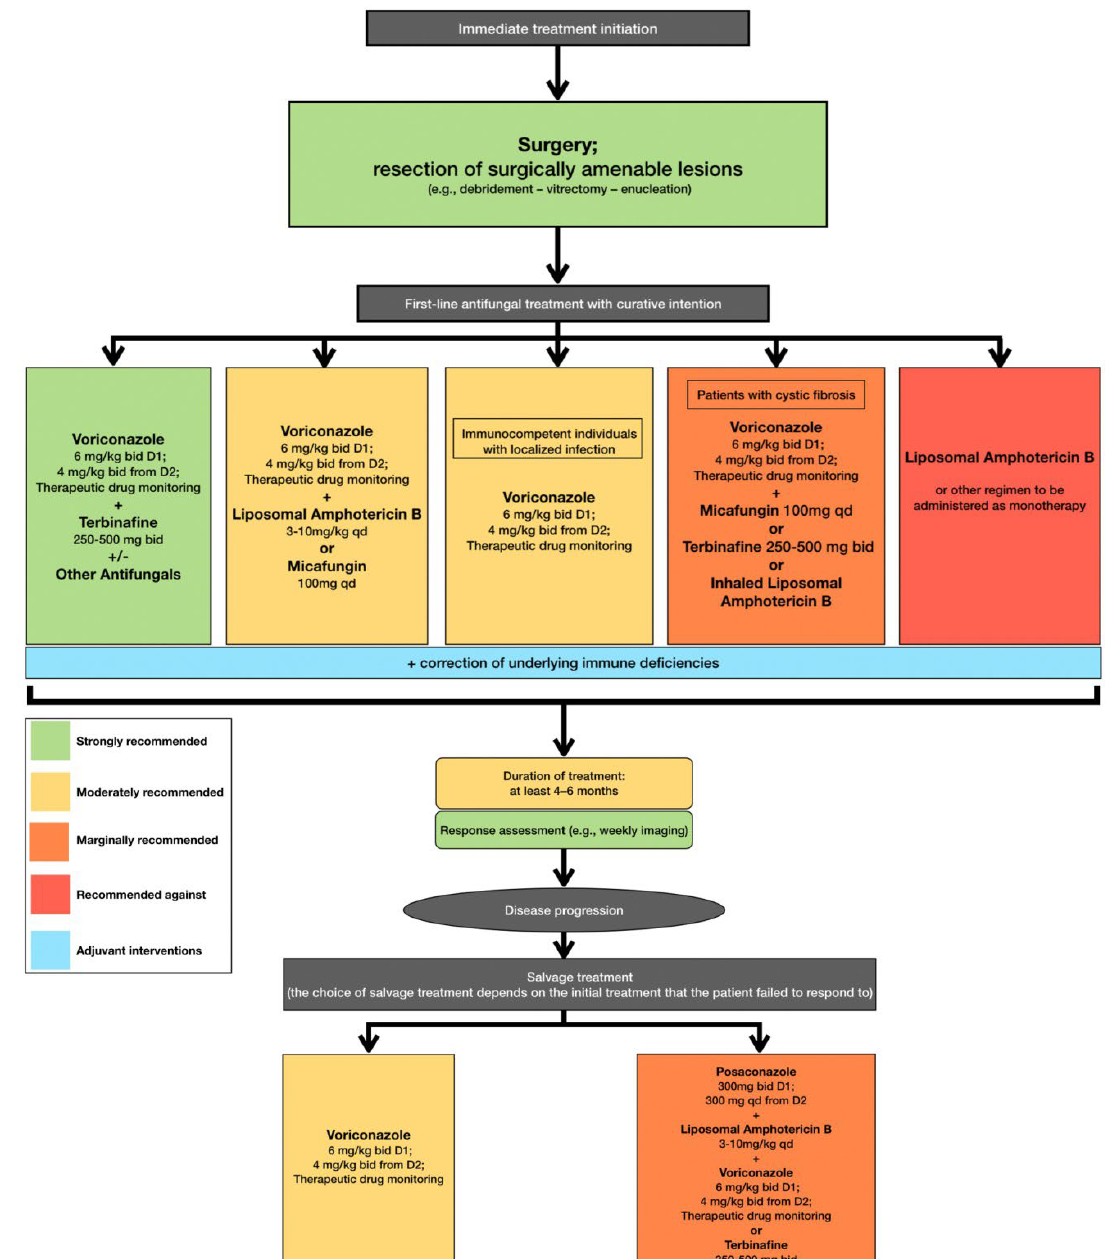
Figure 2. Optimal therapeutical pathway for L. prolificans infections in adults.